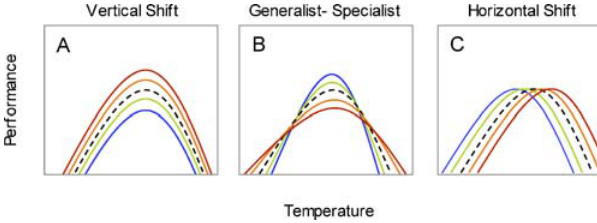
Figure 1. TMV Decomposes Reaction Norm Shape Variation into Three Modes of Variation Vertical shifts produce changes in average performance, horizontal shifts produce changes in the optimal temperature, and generalist-specialist variation produces changes in niche width. An identical template polynomial is shown in each chart as a black dashed reaction norm. The transitions from blue to red curves illustrate hypothetical contributions of the three modes of variation to adaptation to high temperature. DOI: